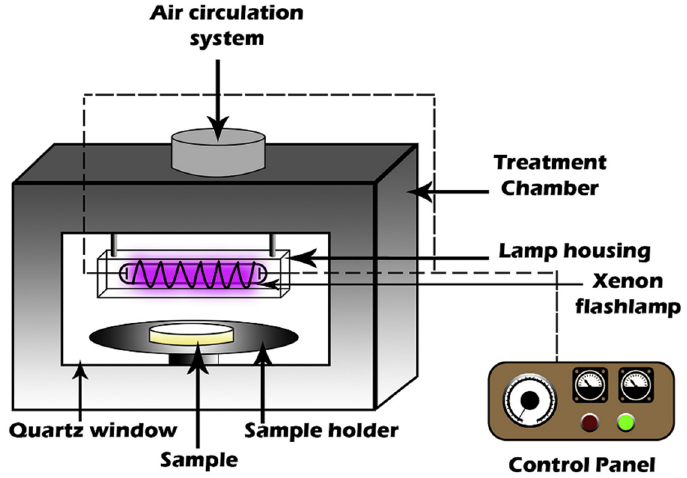
Figure 5. Schematic diagram of a pulsed light (PL) chamber (Source: Mahendran et al. [73]. Permission to use given by Elsevier Science).